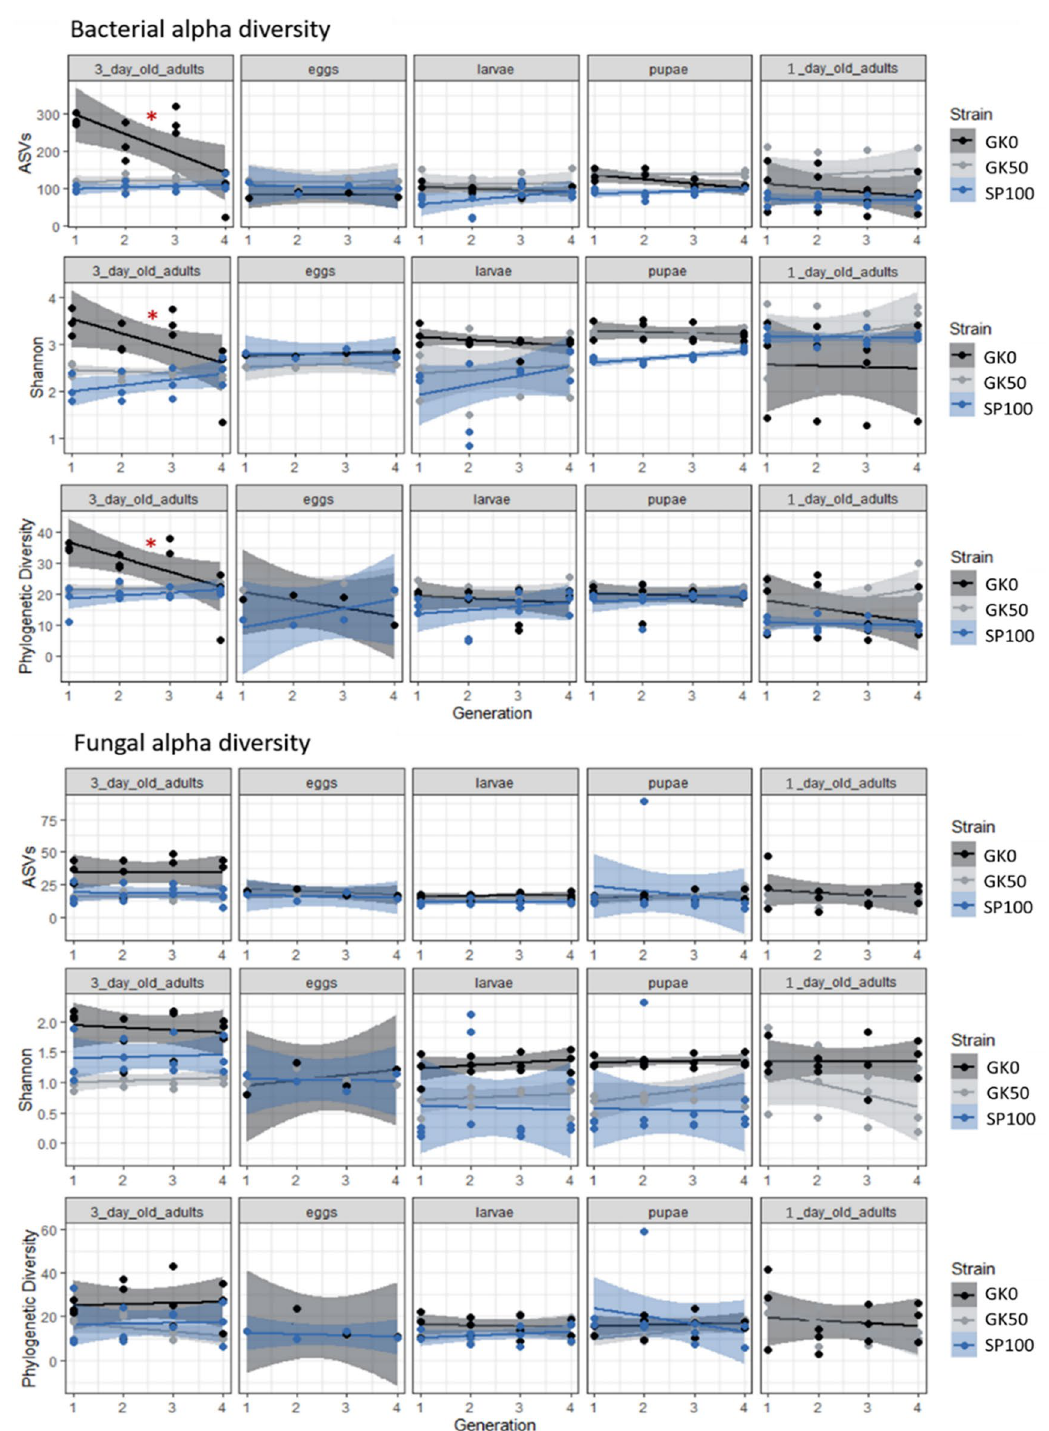
Figure 2. Bacterial and fungal alpha diversity from developmental stages of three Musca domestica strains over four generations, estimated with three diversity metrics: richness represented by the number of different Amplicon Sequence Variants, Shannon index, and Faith’s Phylogenetic Diversity. Each subplot represents a combination of one housefly strain (GK0, GK50, or SP100) and one developmental stage (3 day-old adults, eggs, larvae, pupae, 1-day old adults). Lines show the linear regression for each housefly strain alpha diversity values across generations. The shaded field around the lines stands for the standard error of the linear regression. Alpha diversity decreased significantly only for the bacterial communities derived from older adults of the GK0 strain, as the red asterisk